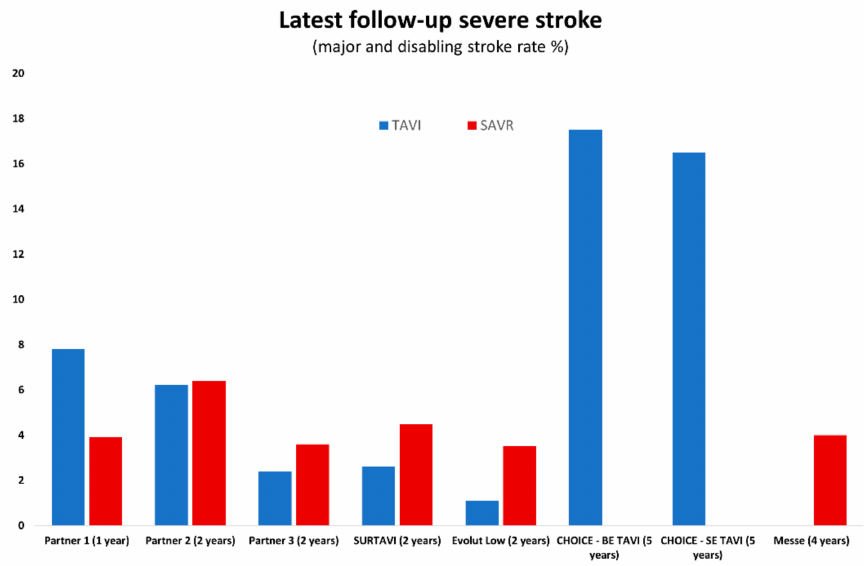
Figure 2. Rates of major and disabling stroke in pivotal trials at most recent follow-up (years from